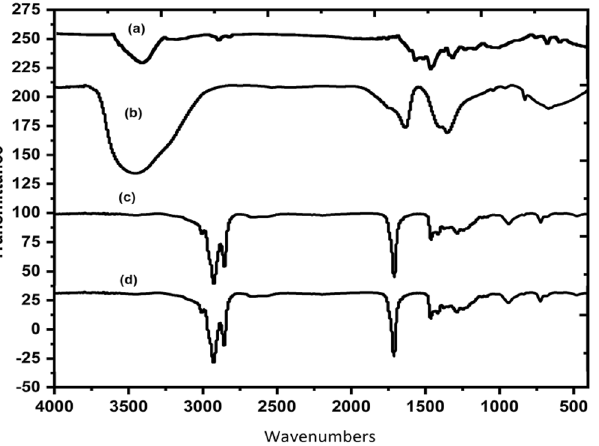
Figure 2. The FTIR spectra of ( a ) the ligand A1, ( b ) C1 complex in aqueous solution, ( c ) TBA.[Pd II -(A1)] (C2) ion pair in aqueous layer and ( d ) TBA.[Pd II -(A1)](C2) ion associate in organic layer.